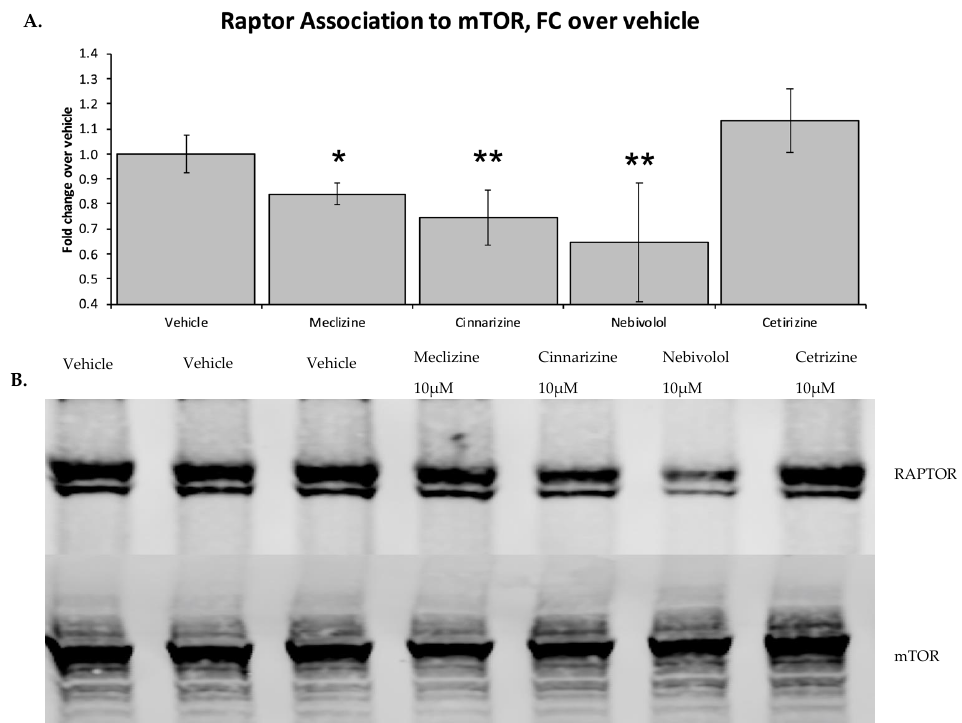
Figure A4. Piperazine molecules significantly block the association of Raptor with mTOR by co-immunoprecipitation. Co-immunoprecipitation showing mTOR and RAPTOR, component of mTORC1 complex. Experiment shows reduced loading of RAPTOR onto mTOR when treated with meclizine, cinnarizine, and nebivolol at 10 µM. This provides a potential mechanism for mTORC1- specific inhibition by piperazine compounds as RAPTOR is only associated with mTOR Complex 1. ( A ) The quantification of the gel, ( B ) bars are means and SD of 2 independent experiments. p -value calculated using two-tailed t-test. Meclizine, cinnarizine, and nebivolol were significantly inhibiting the association of mTOR with RAPTOR, but not cetirizine. Alpha was under 5%. * and ** refer to p- values less than 0.05 and 0.01 respectively.